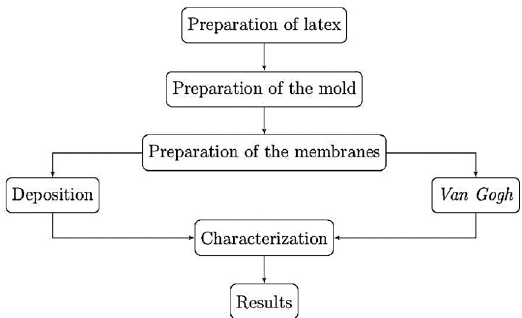
Figure 1. Flowchart of the stages of preparation and characterization of the